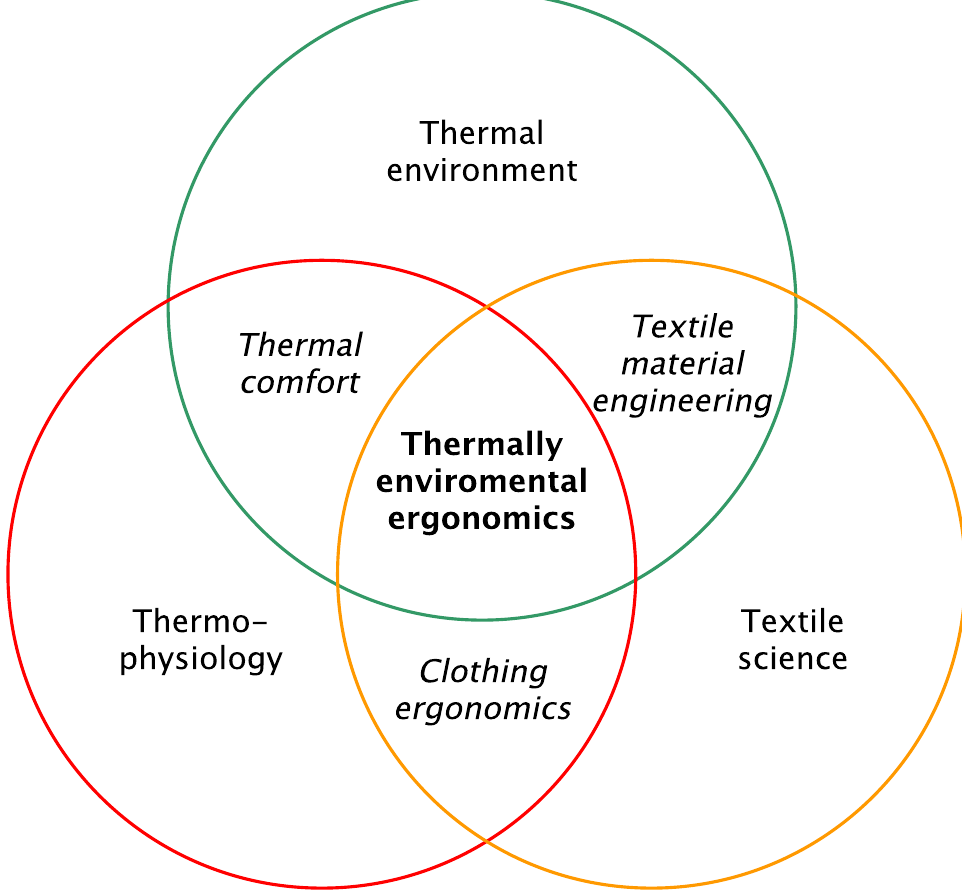
Figure 1. Concepts of thermally environmental